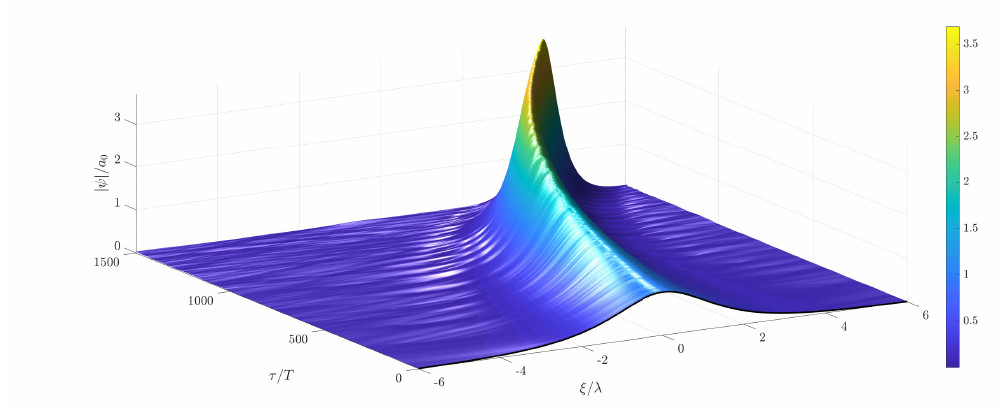
Figure 15. Long-term evolution of a solitary wave solution of the stochastic MNLS with random wind forcing in time. Mean wind velocity V m = 14 m/s and σ v = 5 m/s.